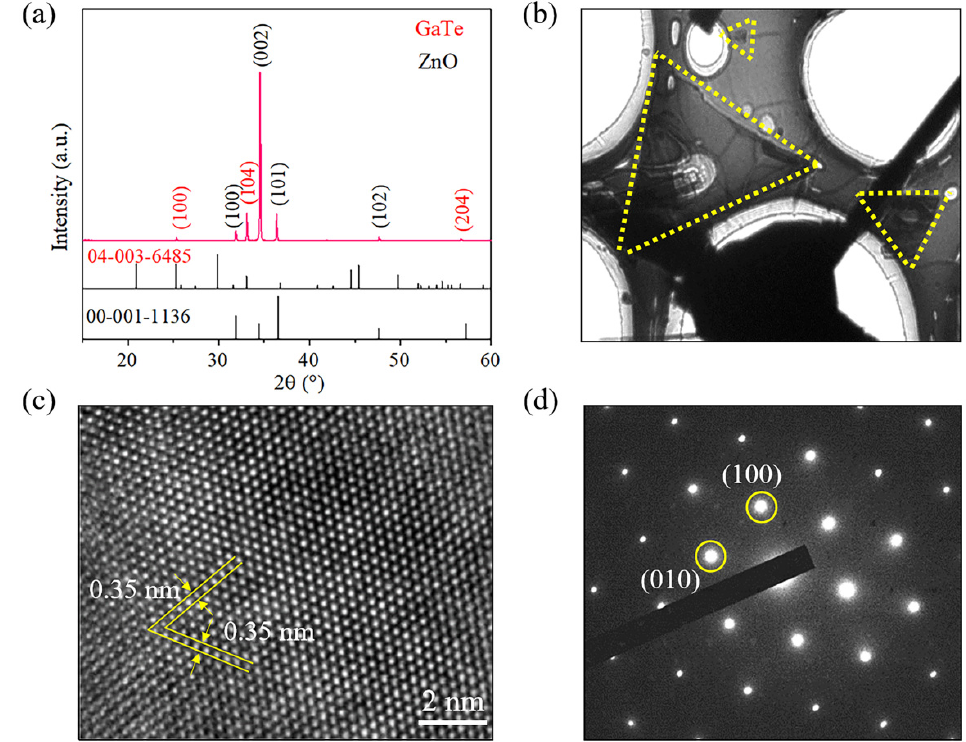
Figure 3. ( a ) XRD pattern of the as-synthesized GaTe nanosheet flower. ( b ) Low-magnification high-angle annular dark-field (HAADF) image of GaTe nanosheet. ( c ) HRTEM image. ( d ) SAED pattern of the 2D GaTe nanosheet, revealing that the 2D GaTe nanosheet has a single-crystal wurtzite structure.